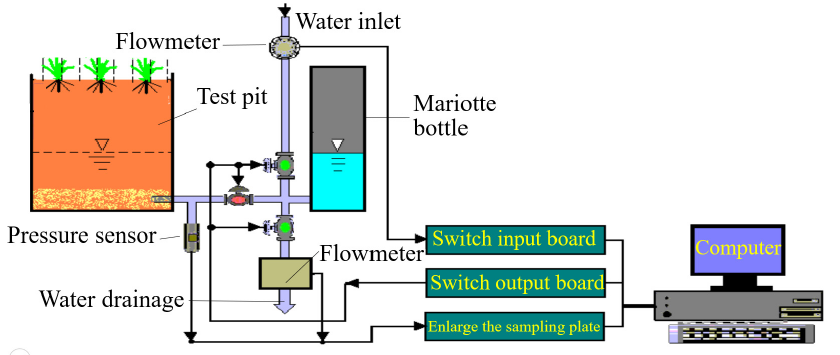
Figure 1. The schematic diagram of the Mariotte bottle system for observing the groundwater contribution of soybeans.